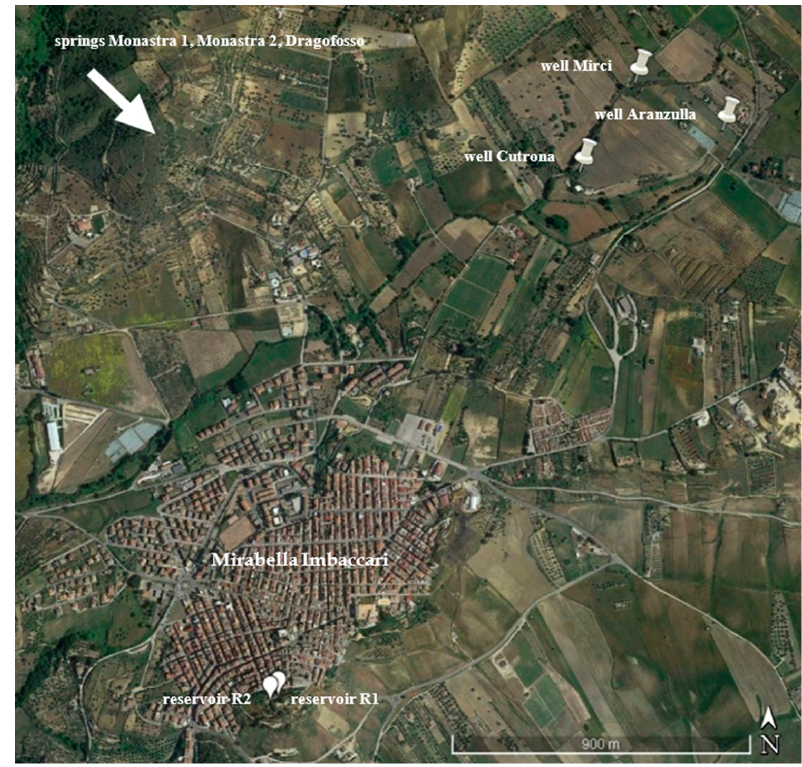
Figure 1. Municipality of Mirabella Imbaccari—location of springs, wells and reservoirs.